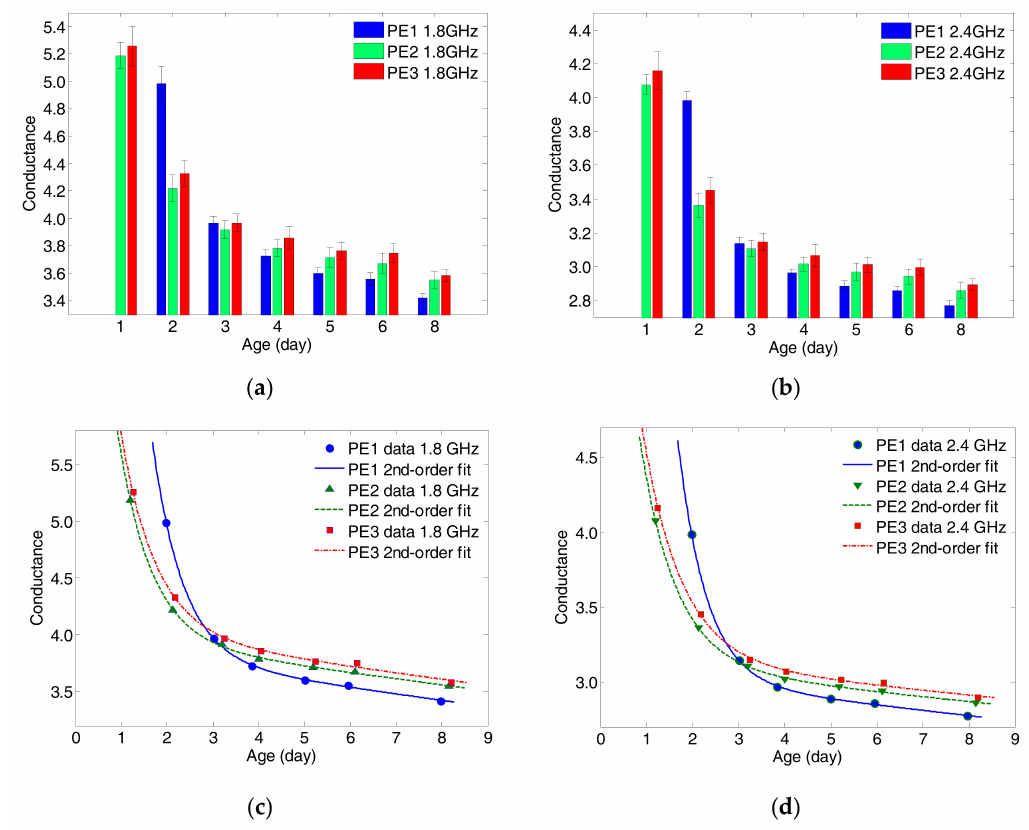
Figure 5. Measured average conductance with standard deviations: ( a ) 1.8 GHz; ( b ) 2.4 GHz; and modeled by using dual-frequency bi-exponential regressions: ( c ) 1.8 GHz; ( d ) 2.4